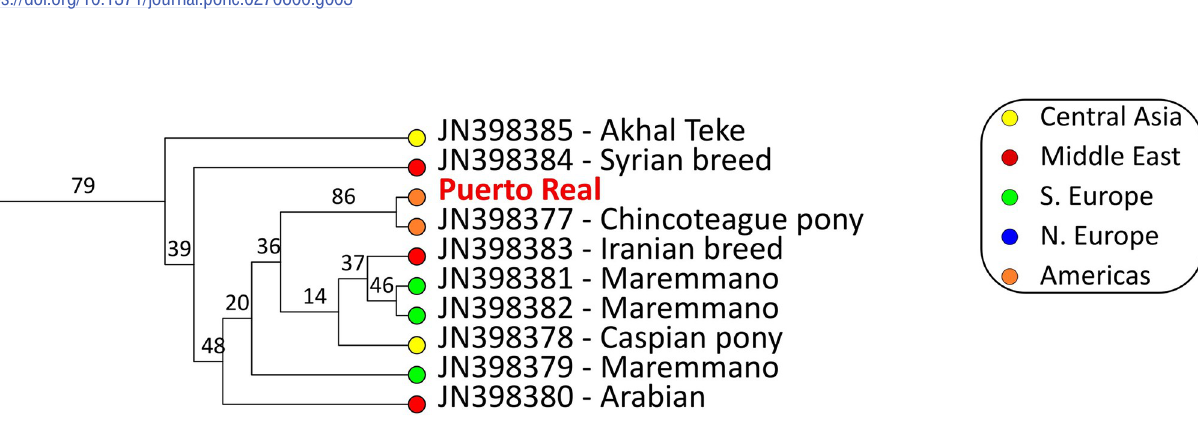
Fig 4. Detail of the haplogroup A phylogeny. The complete phylogeny of all 85 sampled individuals can be found in S2 Fig.